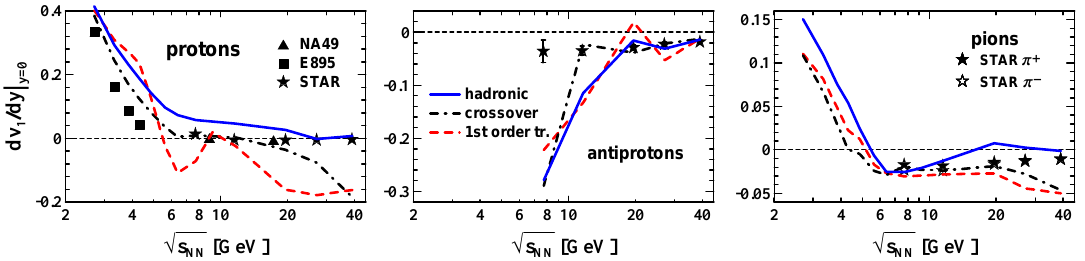
Figure 3. The beam energy dependence of the directed flow slope at midrapidity for protons, antiprotons and pions from mid-central ( b = 6 fm) Au+Au collisions calculated with different EoS’s. The experimental data are from Refs. [14,45,46].